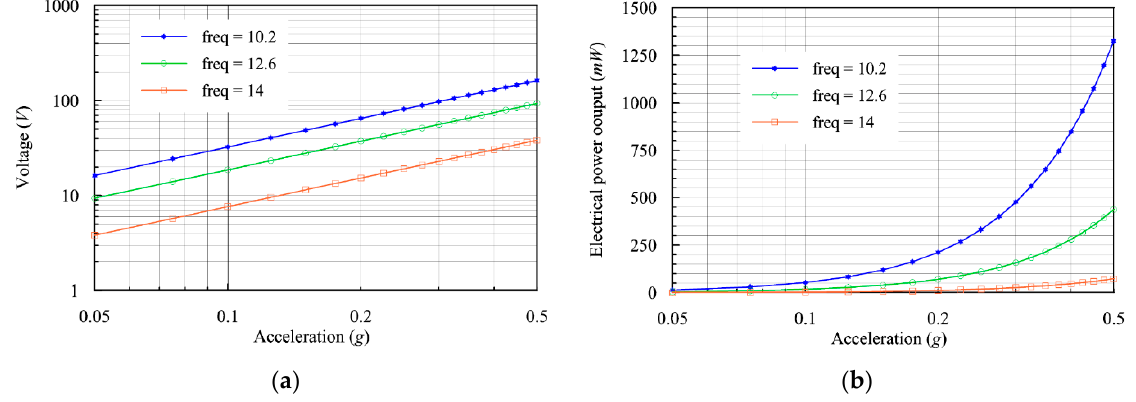
Figure 7. Response variation with acceleration: ( a ) voltage and ( b )